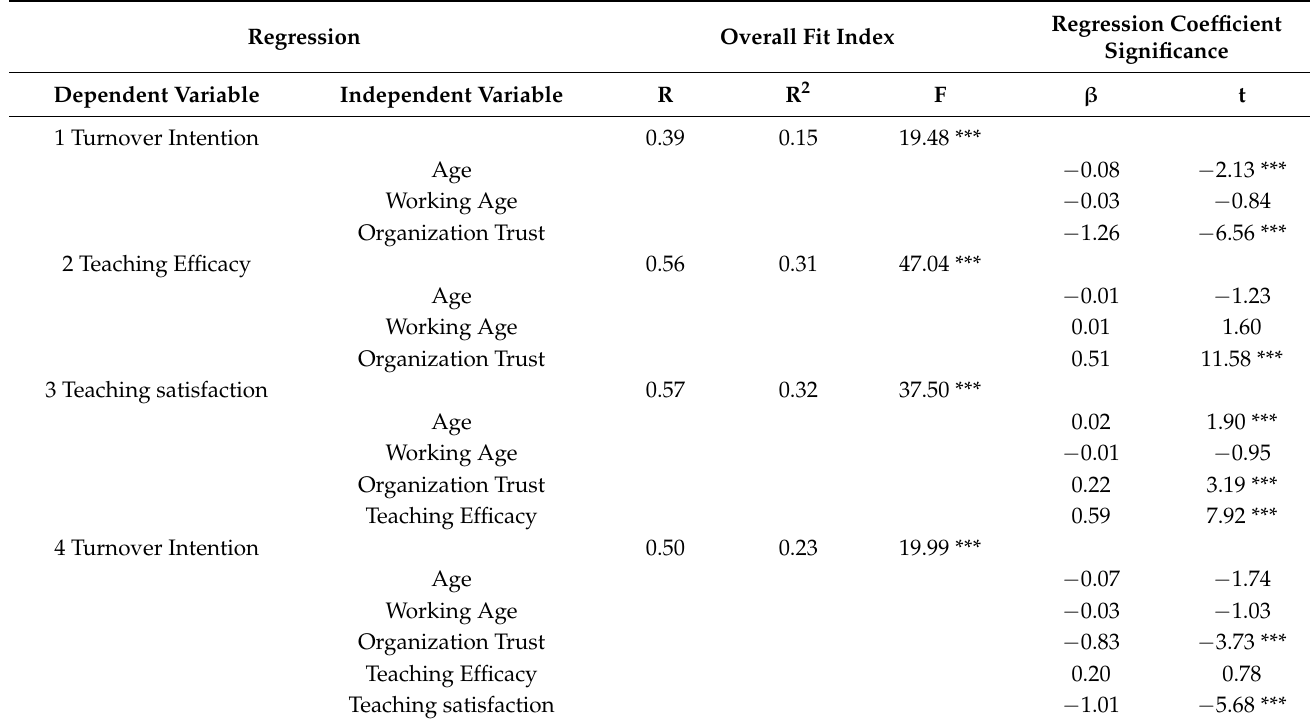
Table 2. The results of regression analysis (models 1–3).